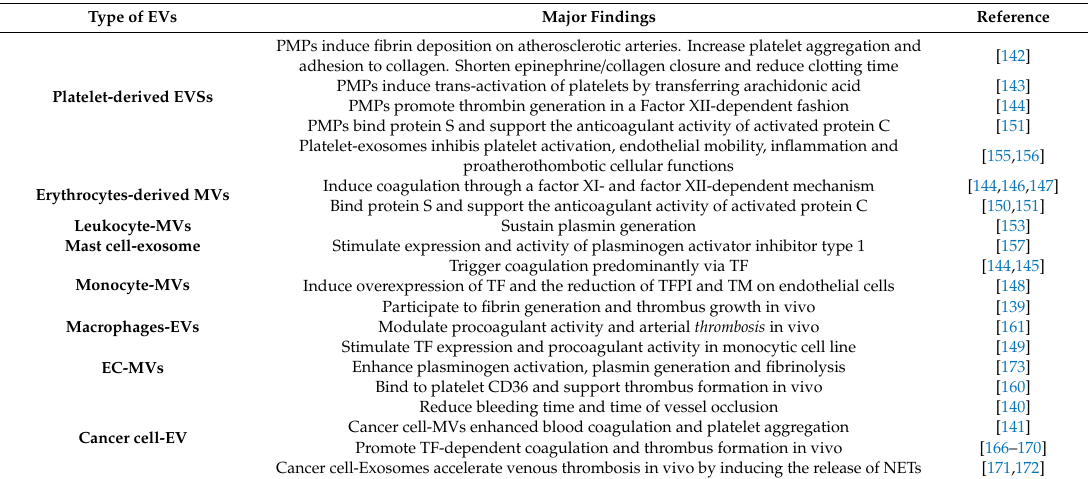
Table 3. Summary of studies investigating the role of EVs in